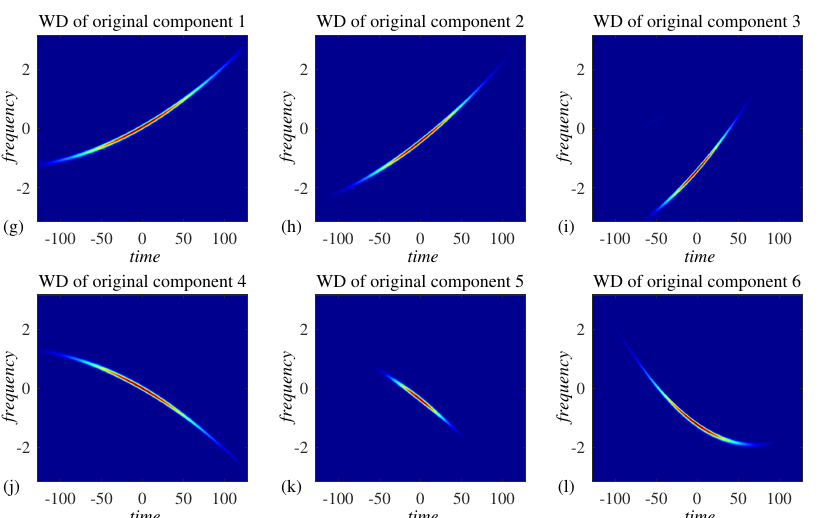
Figure 4. Extracted and original signal components of the non-stationary multicomponent multi- channel signal considered in Example 1. Panels ( a – f ) present extracted using the proposed approach, whereas panels ( g – l ) show Wigner distributions calculated for individual components of the original, noise-free signal.